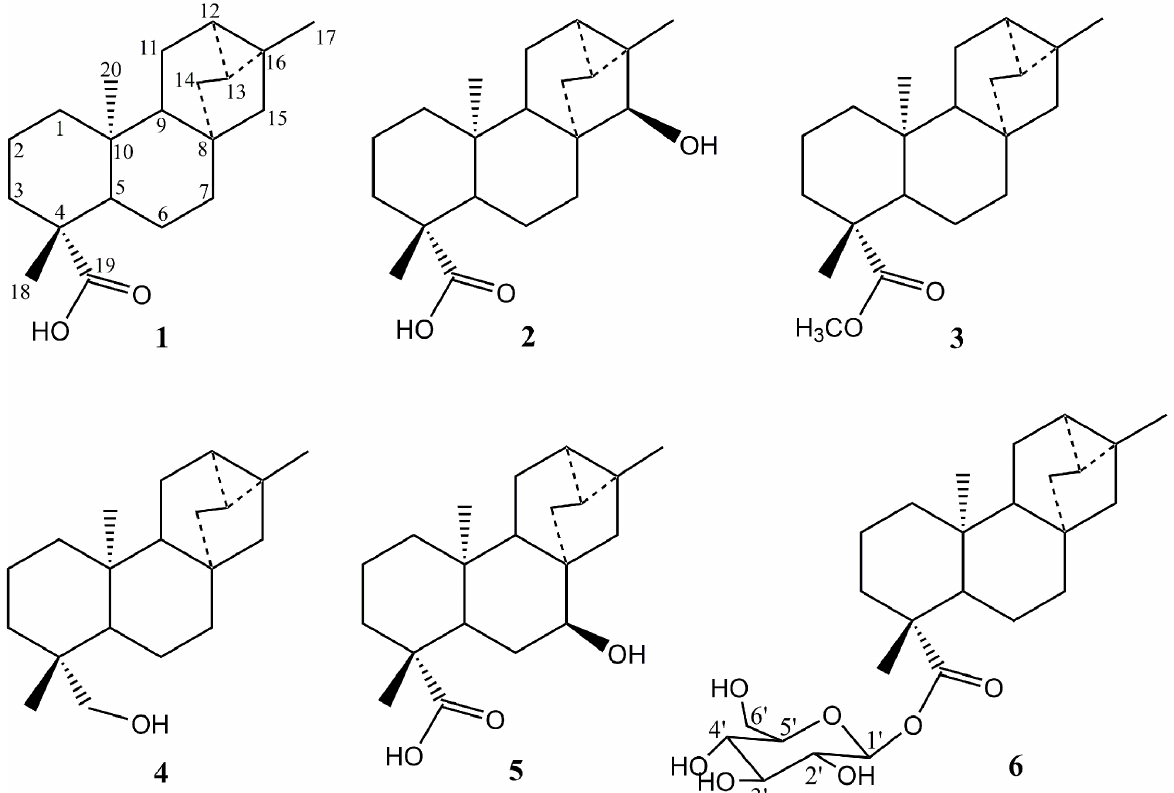
Figure 1 - Chemical structures of compounds 1-6